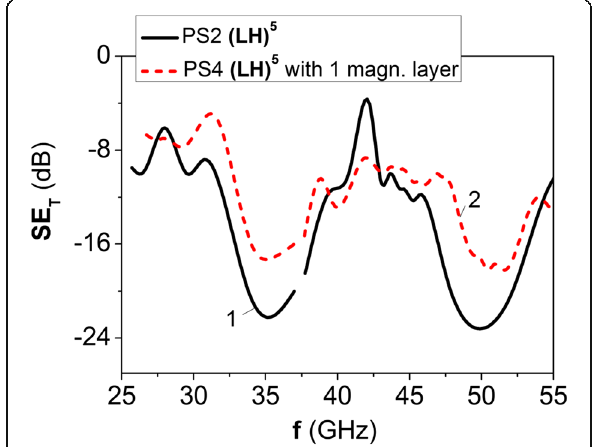
Fig. 5 EMR transmission spectra for 1D PS2 (LH) 5 , that consists of five epoxy layers L285, which alter with composite layers 5 wt.%GNP/L285 ( curve 1 , solid line ) and for PS4 (LH) 5 with one magnetic M-layer (30 wt.%BaM/L285) instead of one 5 wt.%GNP/L285 H-layer ( curve 2 , dashed line